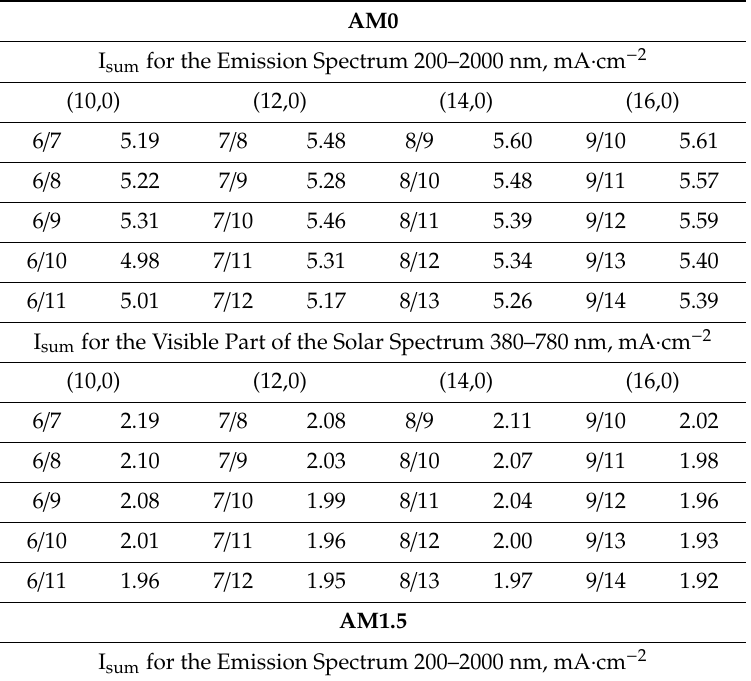
Table 3. Integral value of the photocurrent of composite